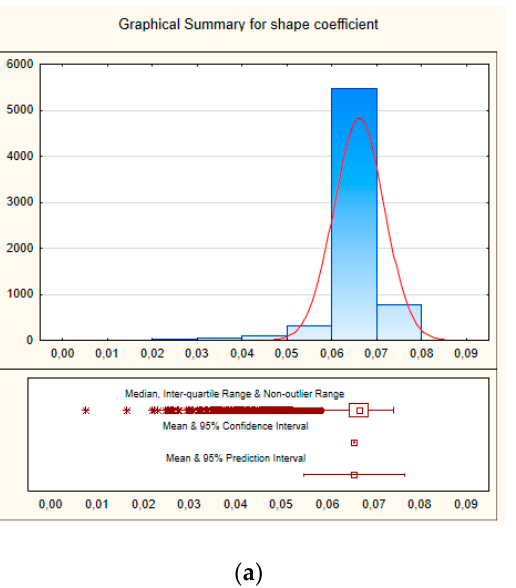
Table 4. Morphology and land cover characteristics of Thiessen polygons (confidence level 95%).